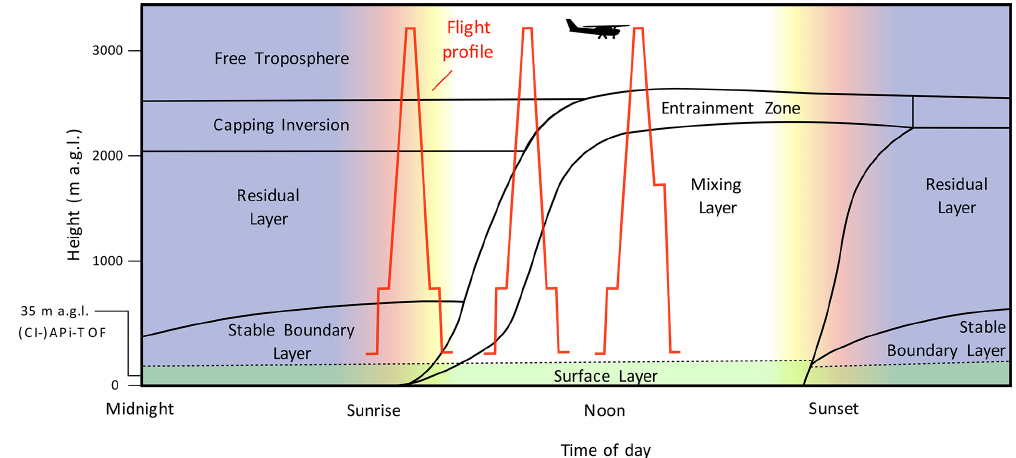
Figure 4. Schematic of the boundary layer development based on Stull (1988) with example height profiles of airborne measurements. The actual layer heights may vary from the values on the values depicted on the vertical axis. The tower with the (CI-)APi-TOF is 35m tall and reaches above the canopy (19ma.g.l. in 2017).